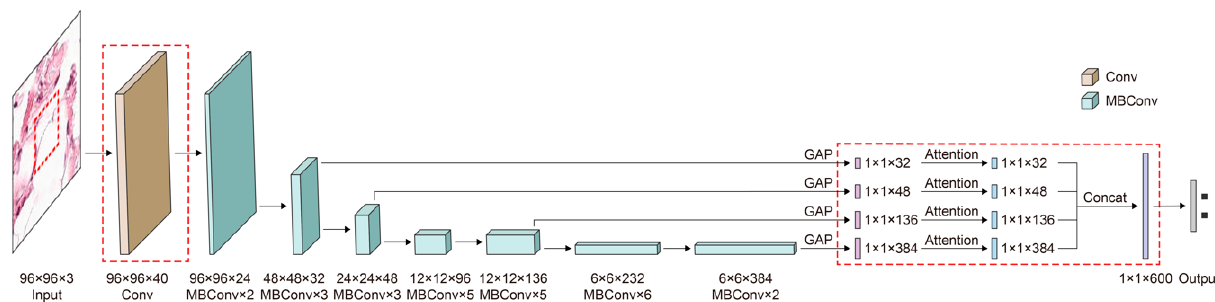
Figure 5. The architecture of boosted-EfficientNet-B3. EfficientNet first extracts image features through its convolutional layers. The attention mechanism is then utilized to reweight features, increasing the activation of significant parts. Next, we perform FF on the outputs of several convolutional layers. Subsequently, images are classified based on those fused features. Details of these methods are described in the following sections.